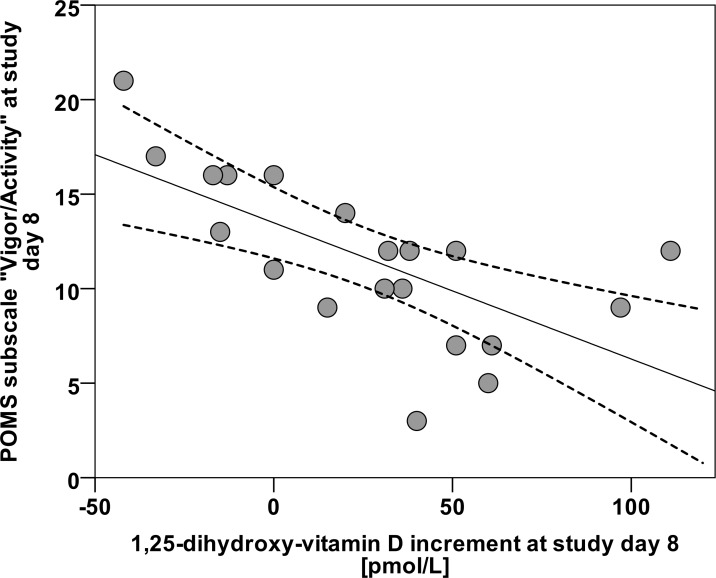
Scatterplot diagram, relationship between POMS subscale Vigor/Activity and the increment in 1,25-dihydroxyvitamin D at day 8 (linear regression analysis, r2 = 0.445, p<0.001). The solid line is the linear fit and dashed lines are the 95% confidence limits to the fit.